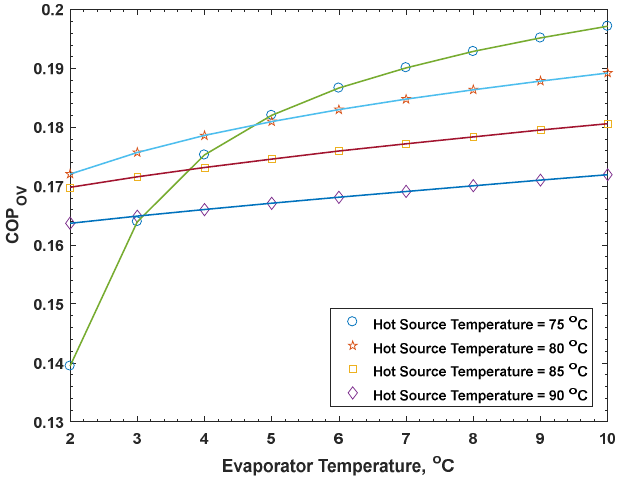
Figure 13. Effect of evaporator temperature on the COP of the overall system.